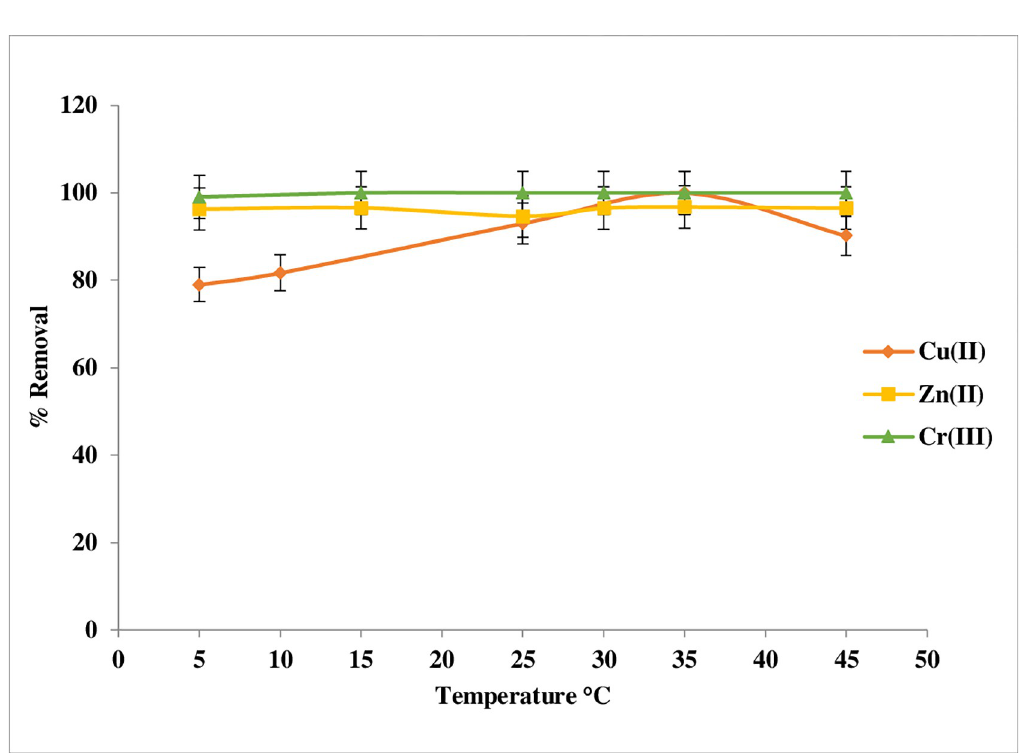
Fig 10. Temperature effect of Cu(II), Zn(II), and Cr(III) adsorption on Imine.